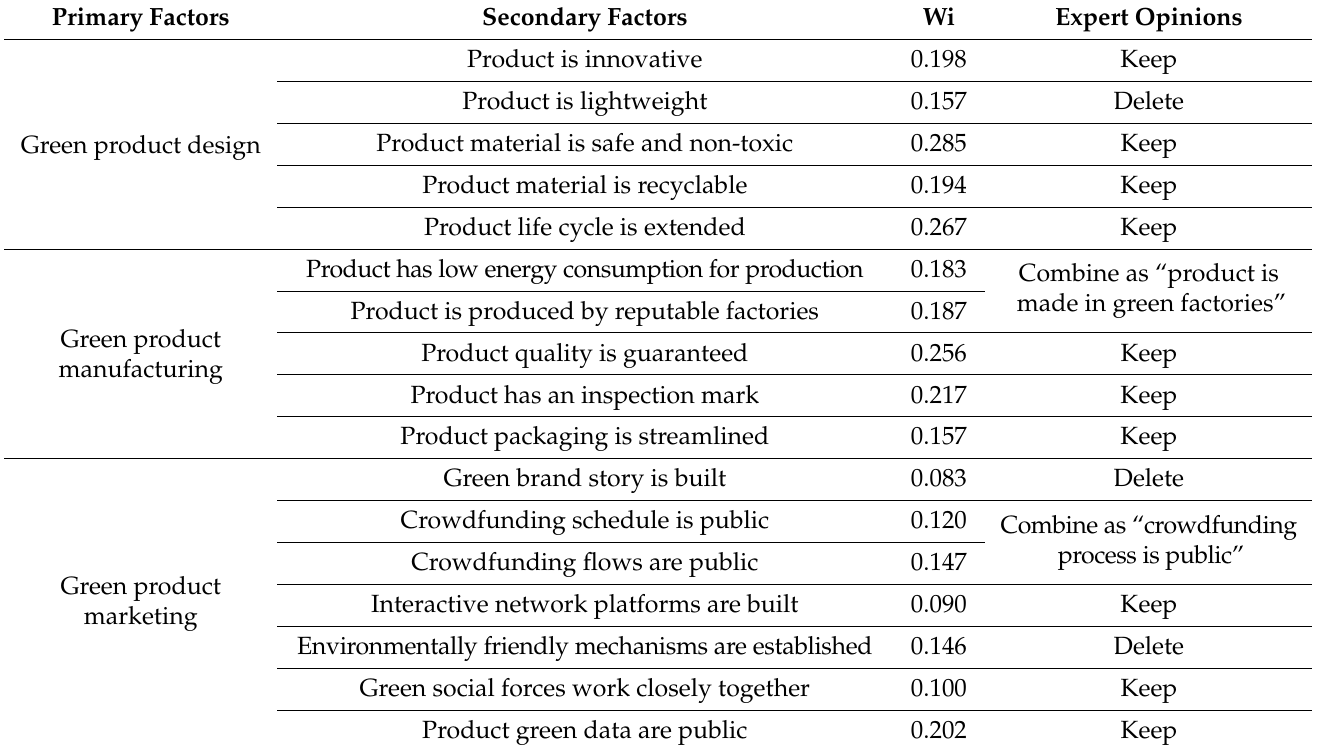
Table 5. Second revision of the factor